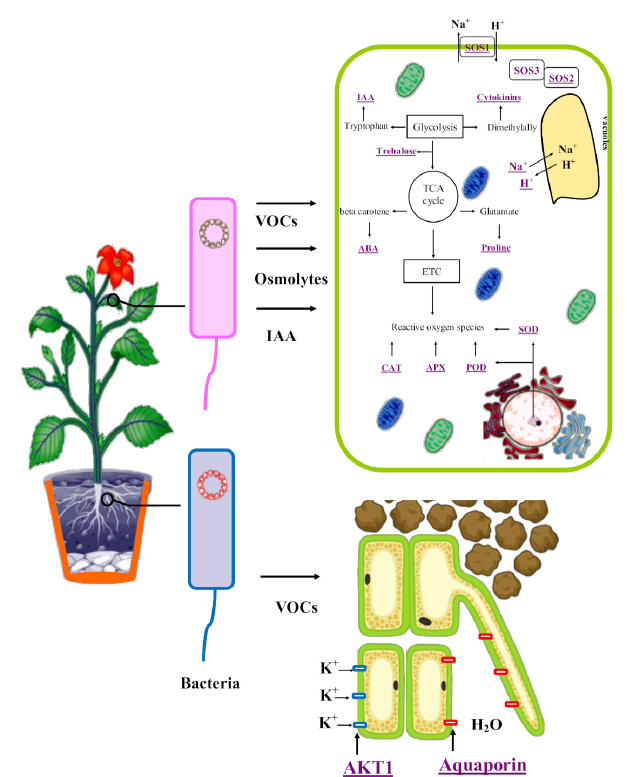
Figure 3. Bacterial mediated plant processes for reducing salt stress, thereby boosting plant growth and development. Rhizosphere and phyllosphere bacteria involved in stress mitigation. Compounds in bold and underlined (pink colored) are up-regulated during plant-bacteria interactions in salt stress mitigation. TCA cycle (tricarboxylic acid cycle); ETC (electron transport chain); IAA (indole